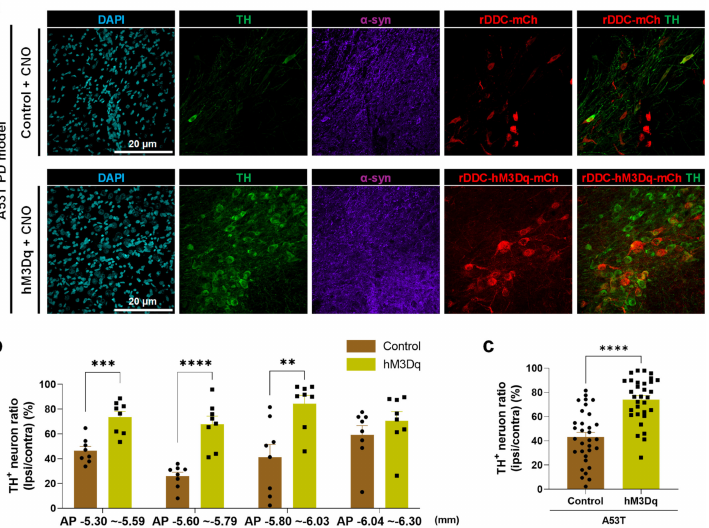
Figure 6. Chemogenetic activation of DDC-positive neurons alleviates the TH loss in SNpc of the A53T rat PD model. ( a ) Representative confocal images of SNpc, which were immunolabeled with anti-TH and anti- α -syn antibodies. Scale bar = 20 µ m; ( b ) the ratio of remaining TH+ neurons in the ipsilateral SNpc compared to the contralateral side at four different coronal sections from rostral to caudal SNpc (Control, n = 8, hM3Dq, n = 8). The number of TH+ neurons in both groups and both hemispheres were counted. The X-axis indicates the anteroposterior (AP) coordinates from bregma; ( c ) bar graph which displays all data from each AP coordinates. The data are presented as the mean ± SEM. The data normality was assessed by Shapiro–Wilk normality test. Statistical significance was calculated by the two-tailed unpaired Student’s t -test. The significance levels are represented as asterisks (** p < 0.01, *** p < 0.001, **** p <